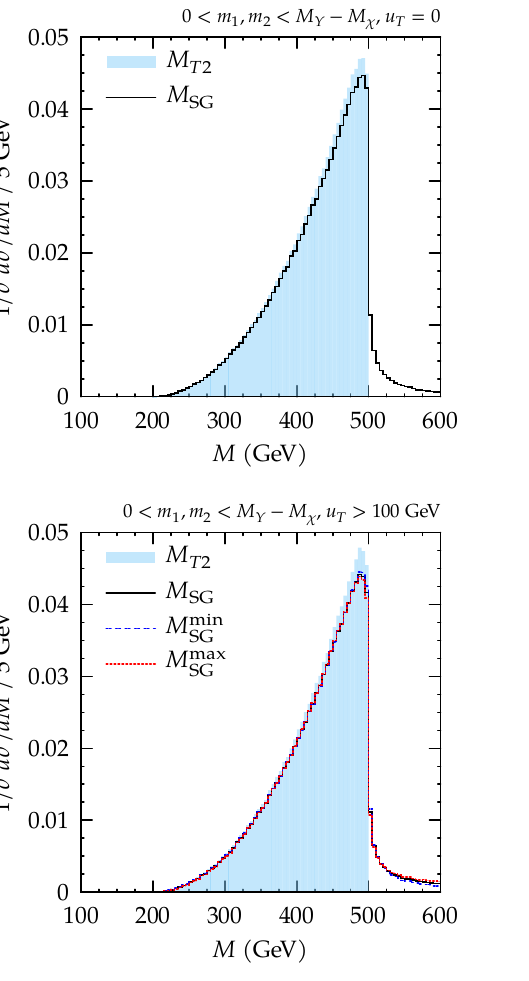
Figure 5 . Distributions of the singularity variables M SG and M T 2 (left) and the number of roots of reduced rank conditions (right) for phase-space events of M Y = 500 GeV and M χ = 200 GeV. The masses of visible particle systems are varying between 0 and M Y − M χ , and we have taken M χ = M true . In the upper panels, the upstream momentum u T is vanishing, while in the lower χ panels, it is larger than 100